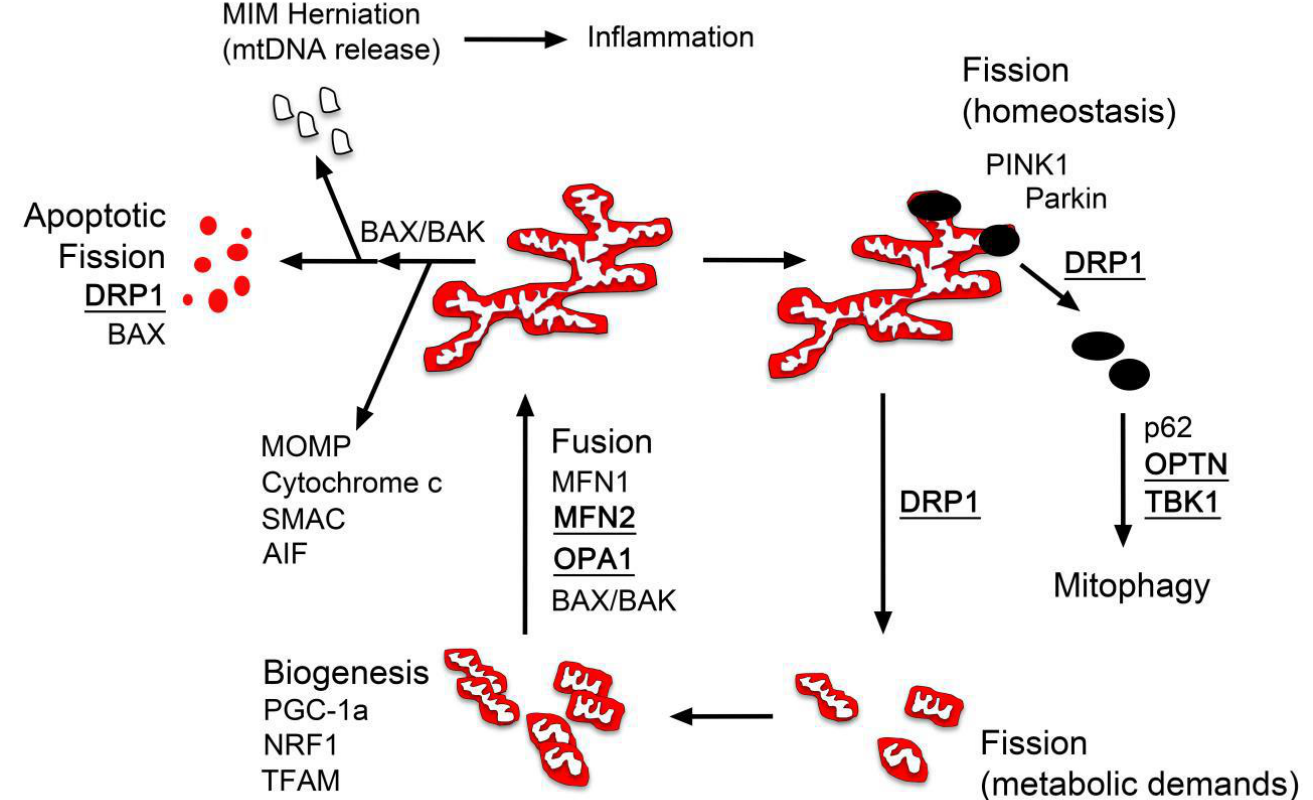
Figure 1. A diagram of mitochondrial dynamics. Mitochondria are in a dynamic flux of fission and fusion, which is determined by factors such as energy/metabolic demands, homeostasis to eliminate damaged or aged organelles, and cell death. This diagram shows some of the relevant gene products that are involved in these processes. Proteins, where mutations within can lead to spontaneous optic atrophy (including Charcot–Marie–Tooth syndrome type 2A) or are associated with familial normal tension glaucoma, are in bold font and underlined (see text). Note that there are three distinct fission mechanisms of reducing mitochondrial size and complexity (homeostasis, metabolic demands, and apoptosis). Abbreviations: MIM, mitochondrial inner membrane; MOMP, mitochondrial outer membrane permeabilization; mtDNA, mitochondrial